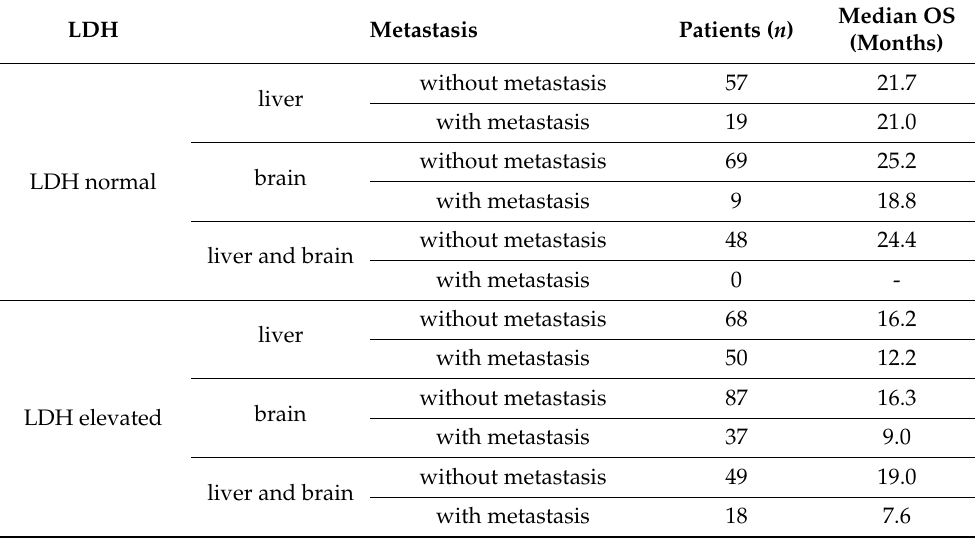
Table 5. LDH influence on OS in metastatic melanoma patients treated with BRAFi/MEKi -> immunotherapy—treatment